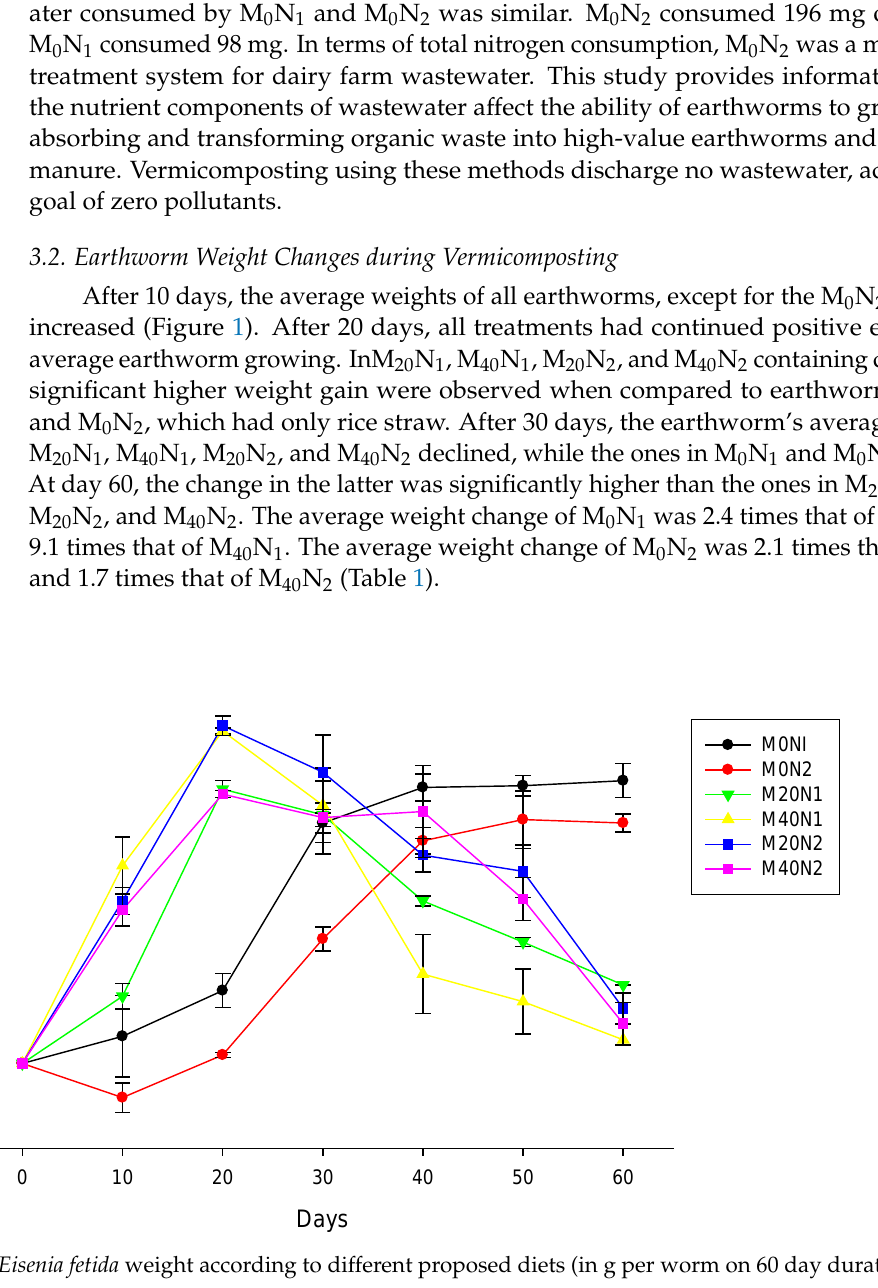
Figure 1. Evolution of Eisenia fetida weight according to different proposed diets (in g per worm on 60 day durations).